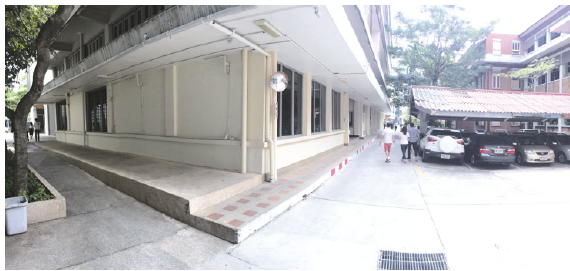
Figure 5: Mechanical Engineering